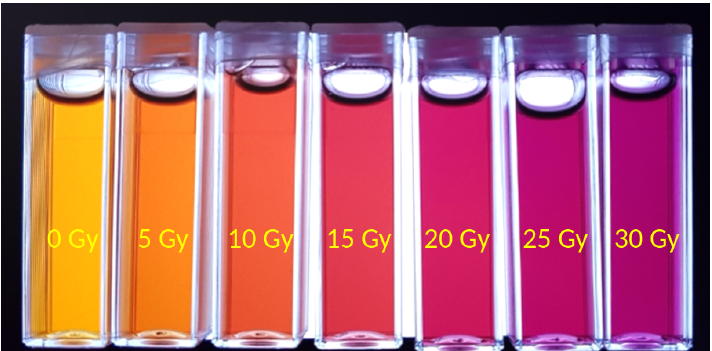
Figure 1. Photograph of Fricke gel samples irradiated up to 30 Gy (from left to right) at 5 Gy increments.